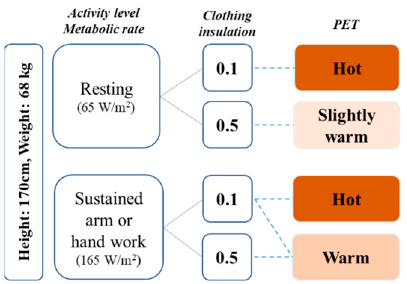
Figure 12. Different PET ranges, based on the microclimatic data on 10 June 2021.